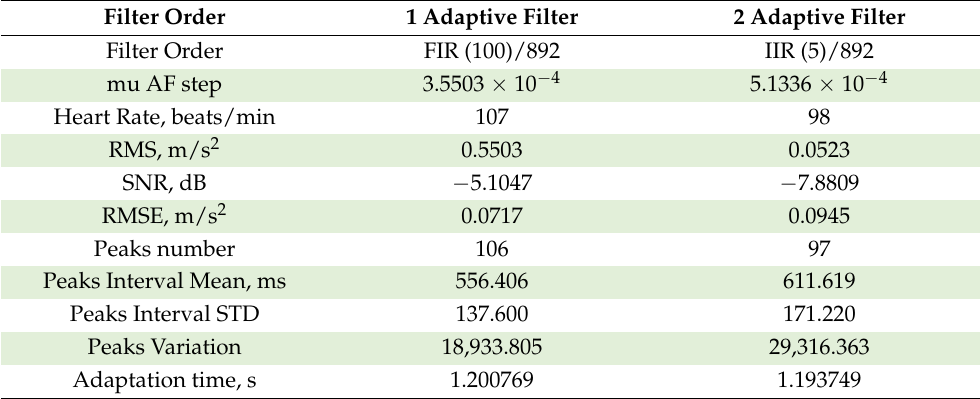
Table 5. Rest SCG signal processing data.